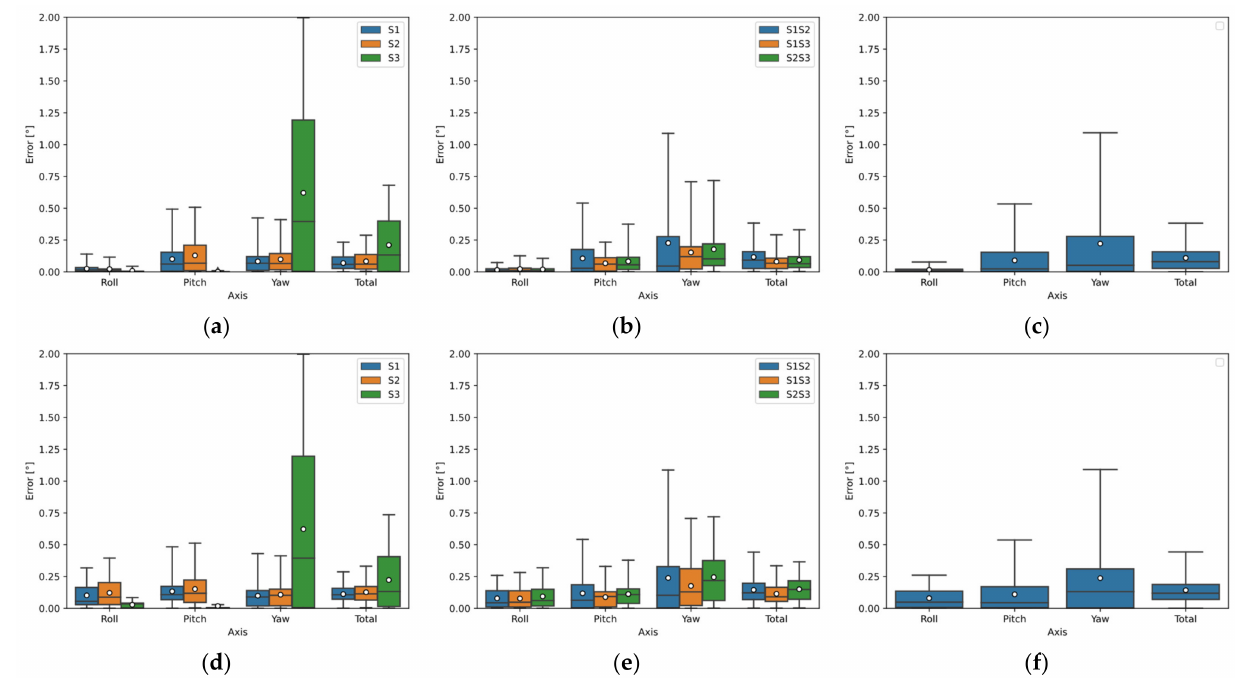
Figure 5. Object A orientation detection error by simulation using Open3D and PCL library: ( a ) sen- sors separately (Open3D); ( b ) two sensors configuration (Open3D); ( c ) three sensors configuration (Open3D); ( d ) sensors separately (PCL); ( e ) two sensors configuration (PCL); ( f ) three sensors config- uration (PCL).